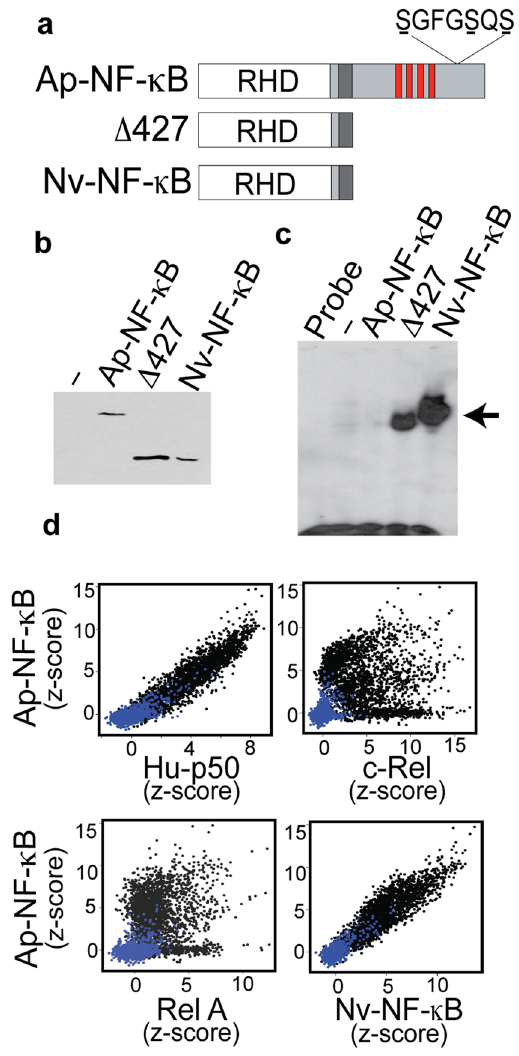
Figure 1. Conserved DNA-binding activity of Ap-NF- κ B. ( a ) Shown are the generalized structures of Ap- NF- κ B, a C-terminal truncation mutant of Ap-NF- κ B ( Δ 427), and the naturally shortened Nv-NF- κ B protein. White: Rel homology domain (RHD). Dark grey: Glycine rich region. Red: Ankyrin repeats. Ap-NF- κ B putative IKK-phosphorylation sites shown. ( b ) Western blot of extracts from human 293 cells transfected with FLAG- tagged versions of the indicated proteins. The relevant section of the scanned film is shown; no other bands were detected on the gel. ( c ) An NF- κ B-site EMSA of extracts from 293 cells transfected with the indicated proteins. The arrow indicates the position of the DNA-protein complex. The free probe is seen as a black band across the bottom of the image. ( d ) Comparison of the PBM-based DNA-binding profile of Aiptasia NF- κ B to human p50, c-Rel, Rel-A, and Nematostella vectensis NF- κ B (Nv) to 2592 κ B sites (black dots) and 1195 random background sites (blue